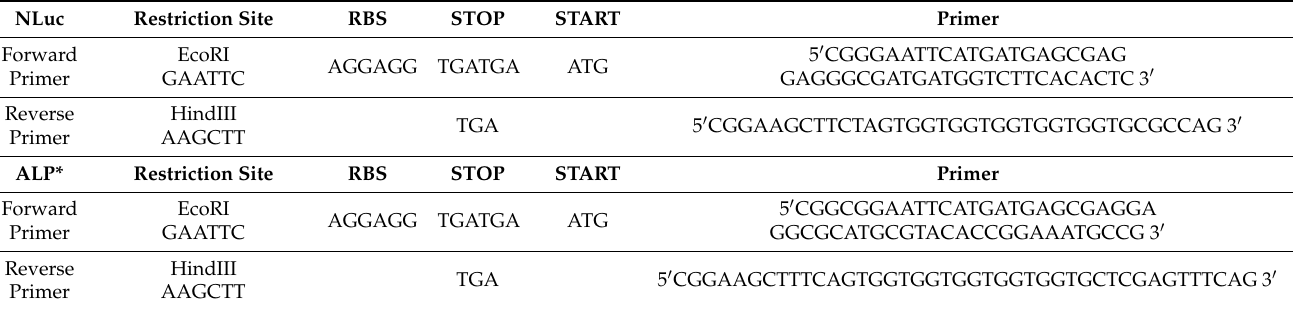
Table 1. Primer sets used to generate and NLuc and ALP* gene inserts for the ligation with the T7Select ® phage vector